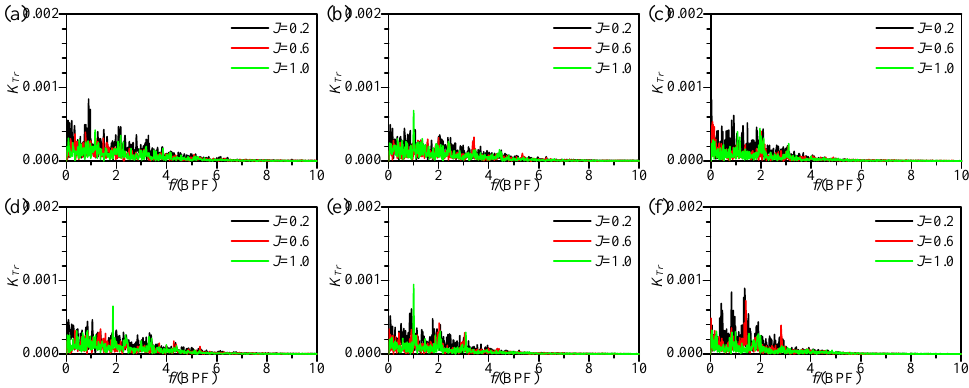
Figure 16. Frequency domain curves of fluctuation component of K Tr . (from ( a – f ) corresponding to PJP model ID 2 to 7).